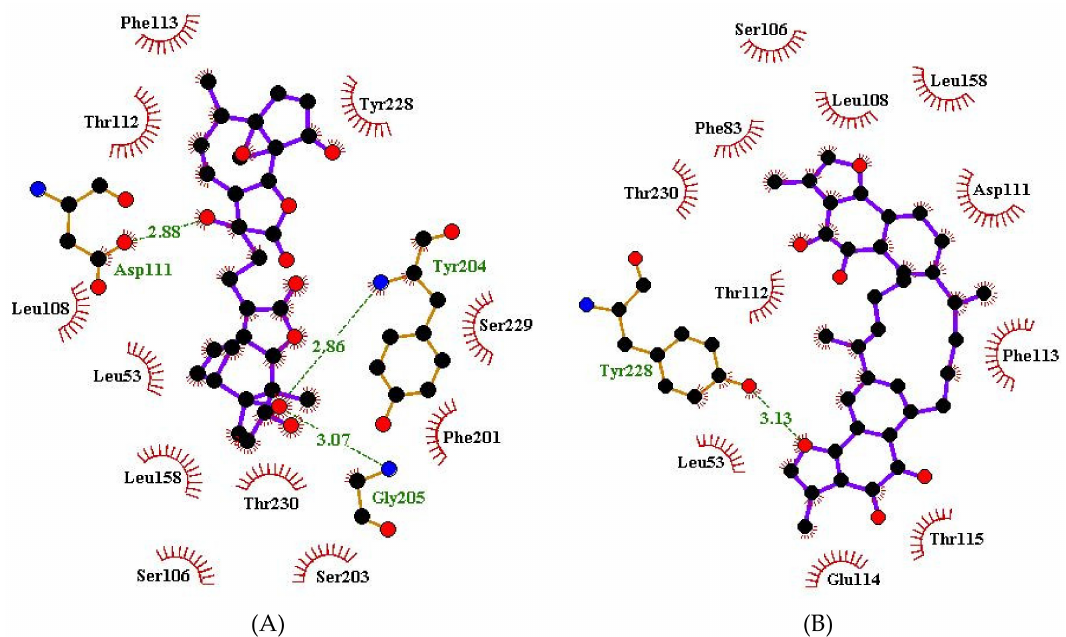
Figure 5. Two-dimensional plots of the WSP-ligand interactions generated using LigPlot+. Interaction profiles of ( A ) WSP-NANPDB5642 complex and ( B ) WSP-ZINC000095913861 complex. Hydrophobic contacts are represented as red spoke arcs, hydrogen bonds are represented as green dash lines and the ligands are colored